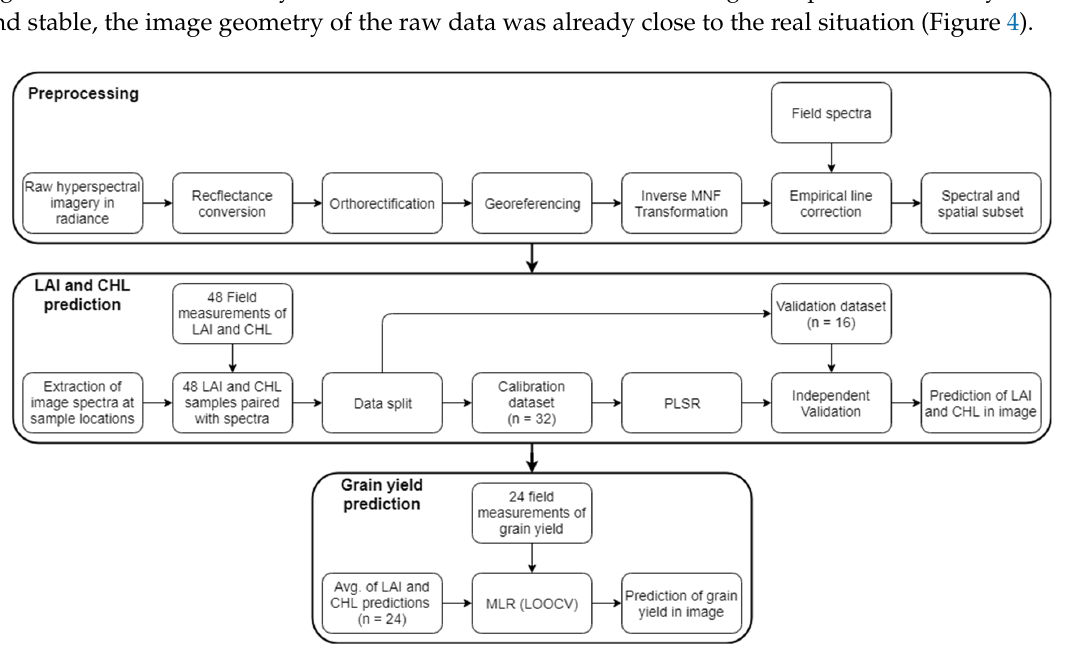
Figure 3. Overview of each performed step during preprocessing and analysis.